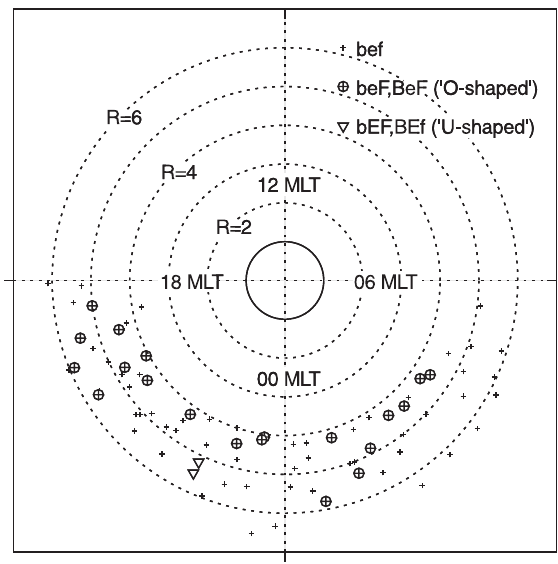
Fig. 8. Same as Fig. 7, but the distance from the center of the figure now gives the radial distance from the Earth in units of Earth radius